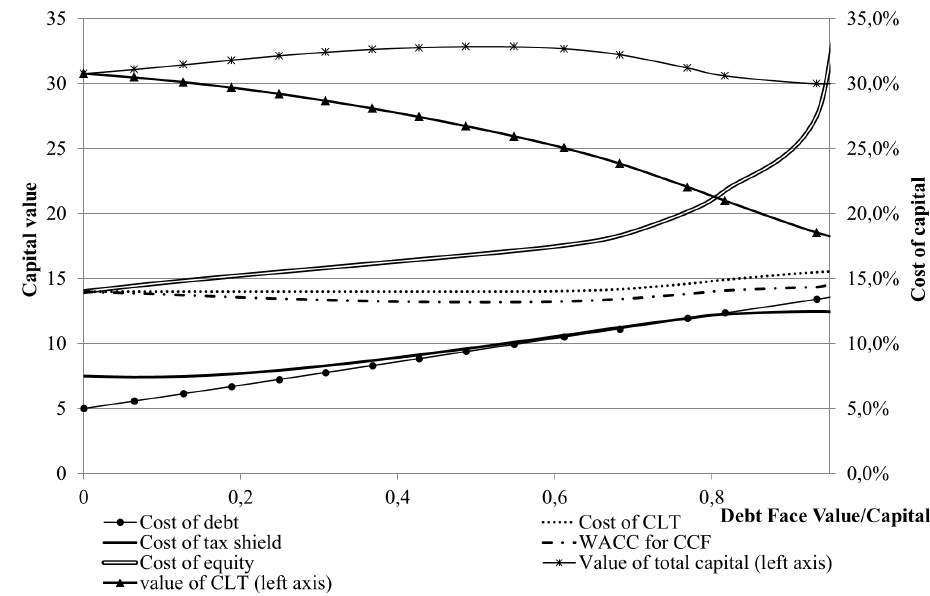
Fig. 5. High-risk-low-growth companies with unstable profits g = 1%, t t = 35%, b =